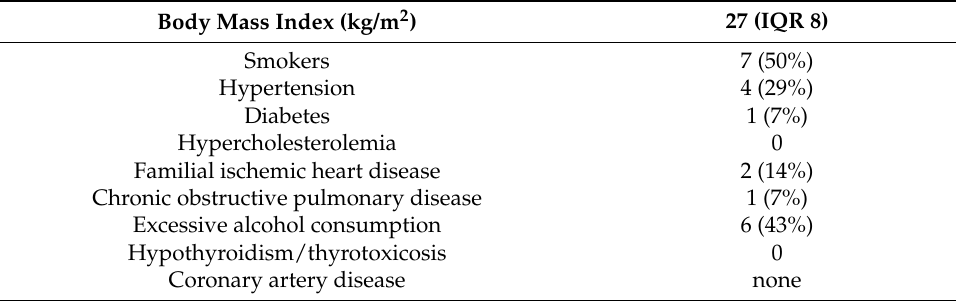
Table 1. Baseline clinical characteristics of included